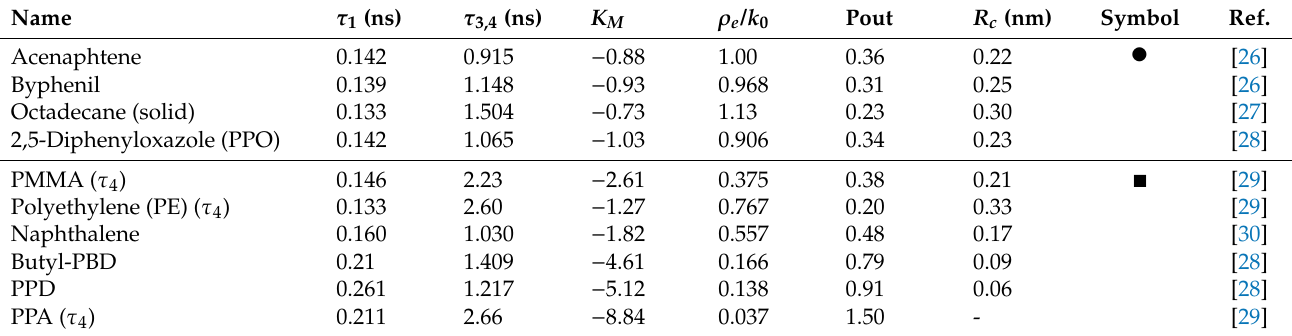
Table 1. Experimental PALS data for some solid materials. Cases with multiple long lifetime components ( τ 3 and τ 4 ), for which only long component is considered, are indicated. The first four rows correspond to only samples for which the correct ratio between signal intensities was respected. Fourth and fifth columns report calculated K M and ρ e / k 0 . Sixth and seventh columns are discussed in next section. These materials are represented in Figures 2 and 3, with symbols listed in eighth column of table. Acronyms PMMA, PPD, and PPA stand for Polymethylmethacrylate, 2,5-Diphenyl 1,3,4 oxadiazole, and Atactic polypropylene, respectively.